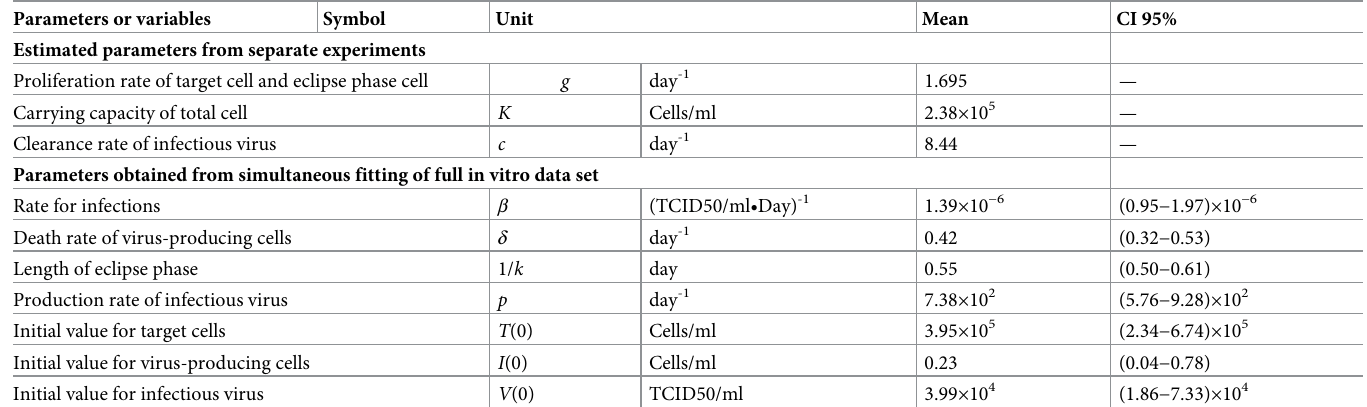
Table 2. Estimated kinetic parameters and initial values.